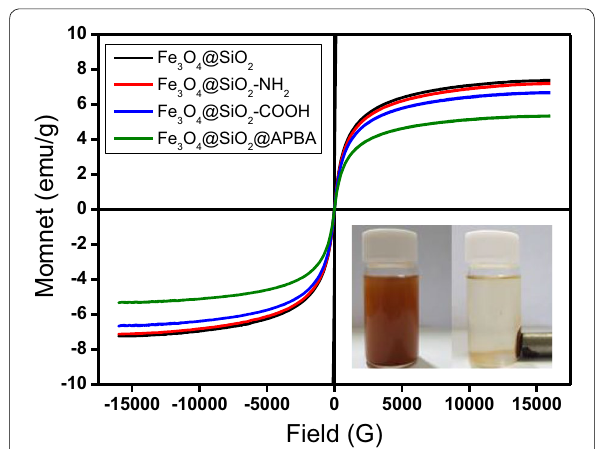
Fig. 3 Hysteresis loops of as‑prepared samples featuring different surface functional